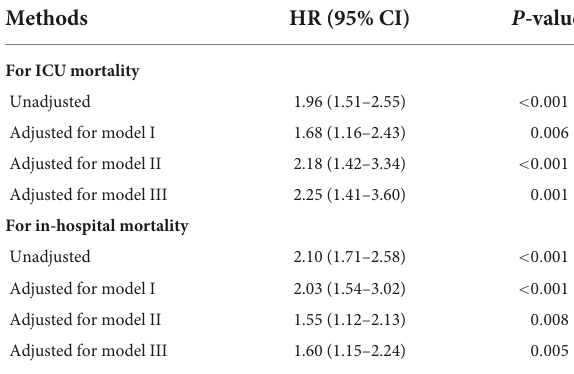
TABLE 6 Univariate and multivariate Cox regression analyses for clinical